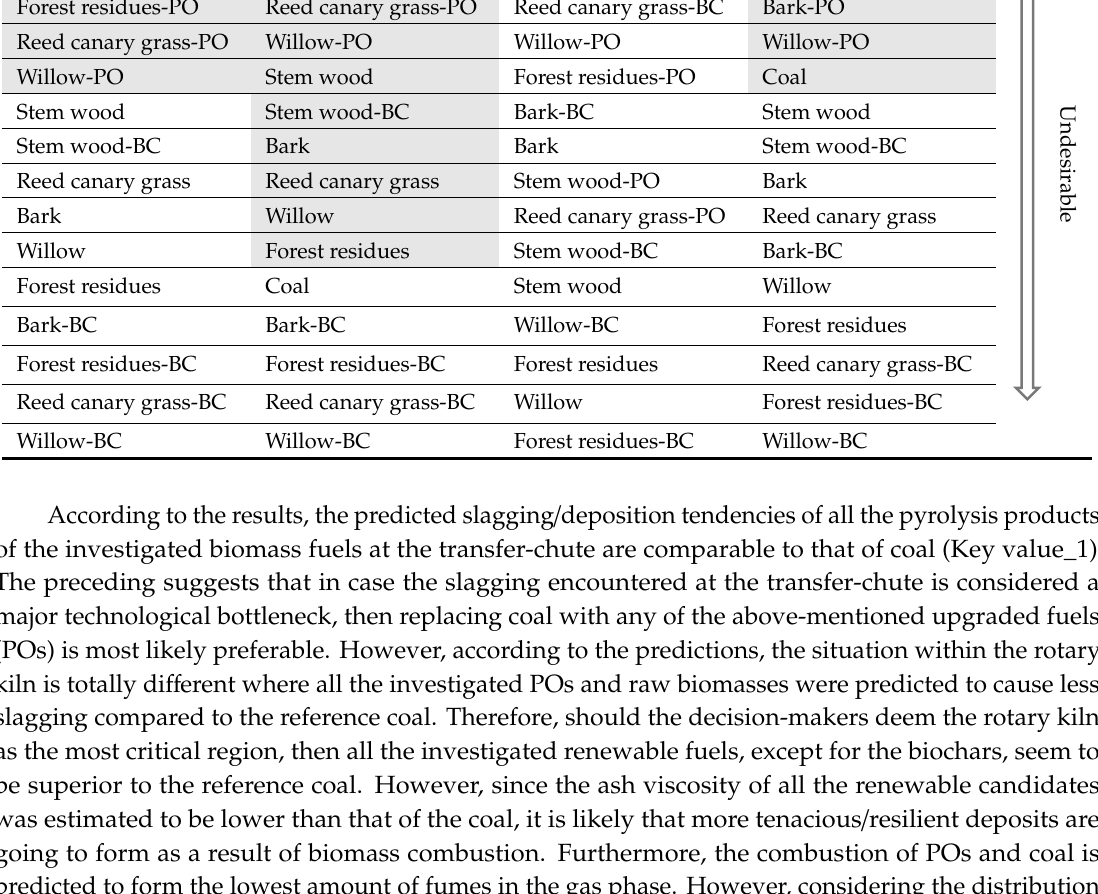
Table 1. The calculated slagging potential for the investigated fuels; Column A representing the calculated slagging potential for the transfer-chute (ADTs from Equation (2)); Column B representing that calculated for the transfer-chute (ADTs from Equation (5)); Column C representing that calculated for the rotary kiln (ADTs from Equation (5)). Each color represents a certain category of the investigated fuels where coal is indicated by blue, raw biomass, PO, and biochars are indicated by yellow, green, and gray, respectively. PO and BC stand for pyrolysis oil and biochar,